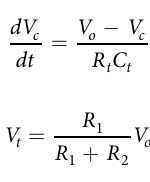
where V o < V c , R t = 10 kΩ; otherwise R t = 100 kΩ. R 2 = 2 kΩ.